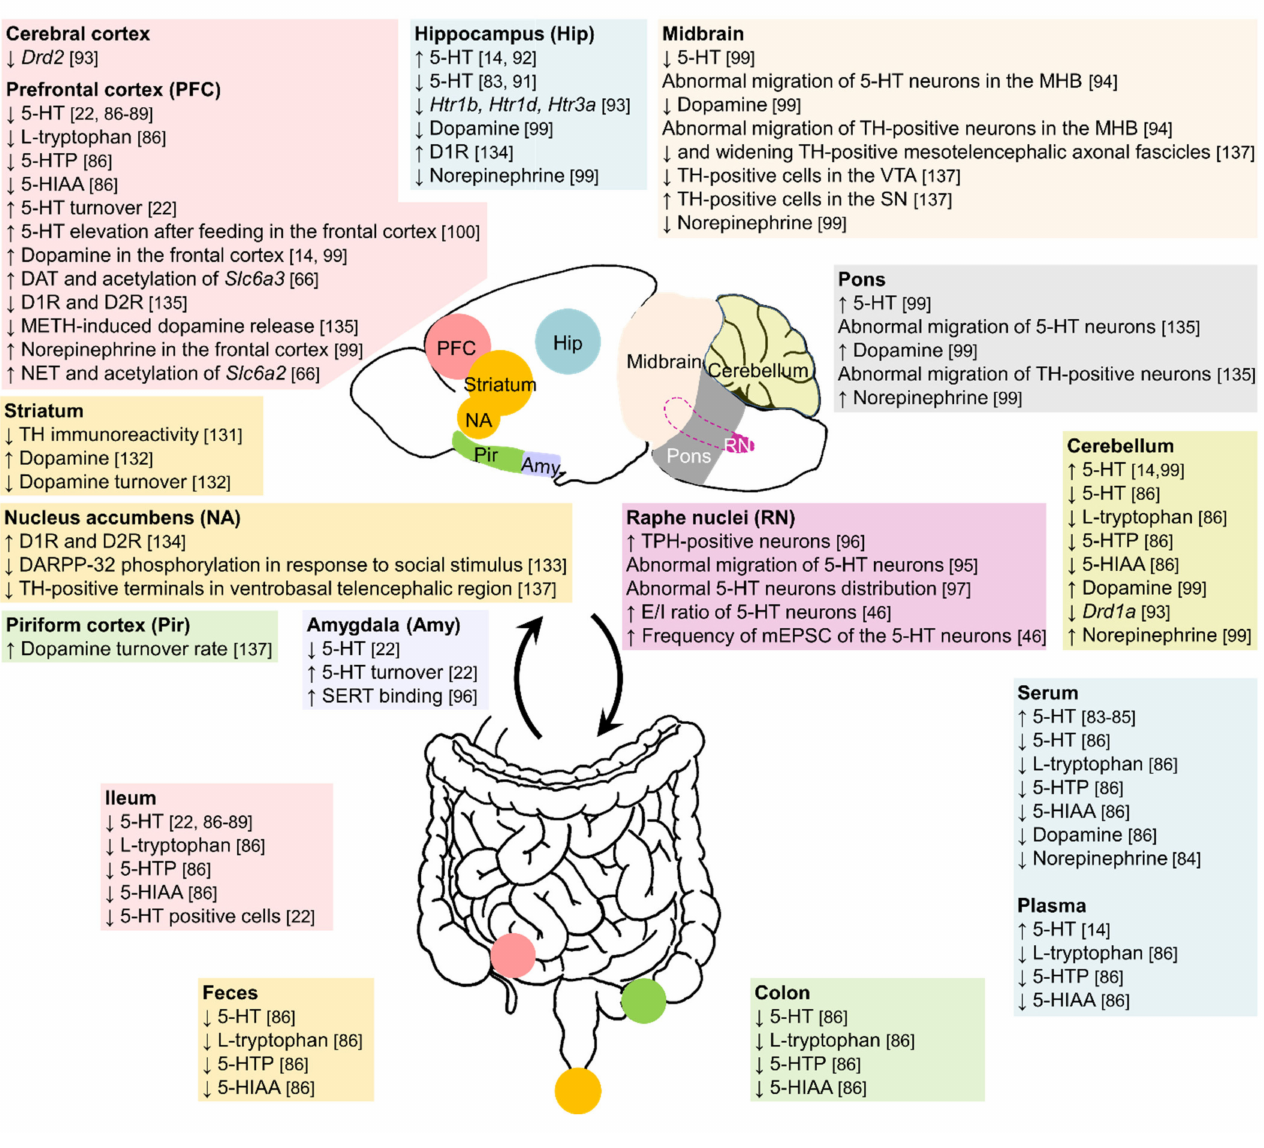
Figure 1. Alterations of monoaminergic systems in the brain and peripheral system of mater- nally VPA-treated rodent offspring. Schematic drawings illustrate pathophysiological changes in monoaminergic systems in the central nervous system and peripheral system of maternally VPA- treated rodent offspring. The bi-directional arrows indicate cross-talk between the central and peripheral systems. Abbreviations: ↑ , increased; ↓ , decreased; 5-HIAA, 5-hydroxyindoleacetic acid; 5-HT, 5-hydroxytryptamine (serotonin); 5-HTP, 5-hydroxytryptophan; D1R, dopamine D1 recep- tor; D2R, dopamine D2 receptor; DAT, dopamine transporter; DOPAC, 3,4-dihydroxyphenylacetic acid; E/I, excitatory/inhibitory; Htr, 5-hydroxytryptamine receptors; mEPSCs, miniature excitatory postsynaptic currents; METH, methamphetamine; MHB, midbrain-hindbrain boundary; NET, nore- pinephrine transporter; SERT, serotonin transporter; SN, substantia nigra; TH, tyrosine hydroxylase; TPH, tryptophan hydroxylase; VTA, ventral tegmental